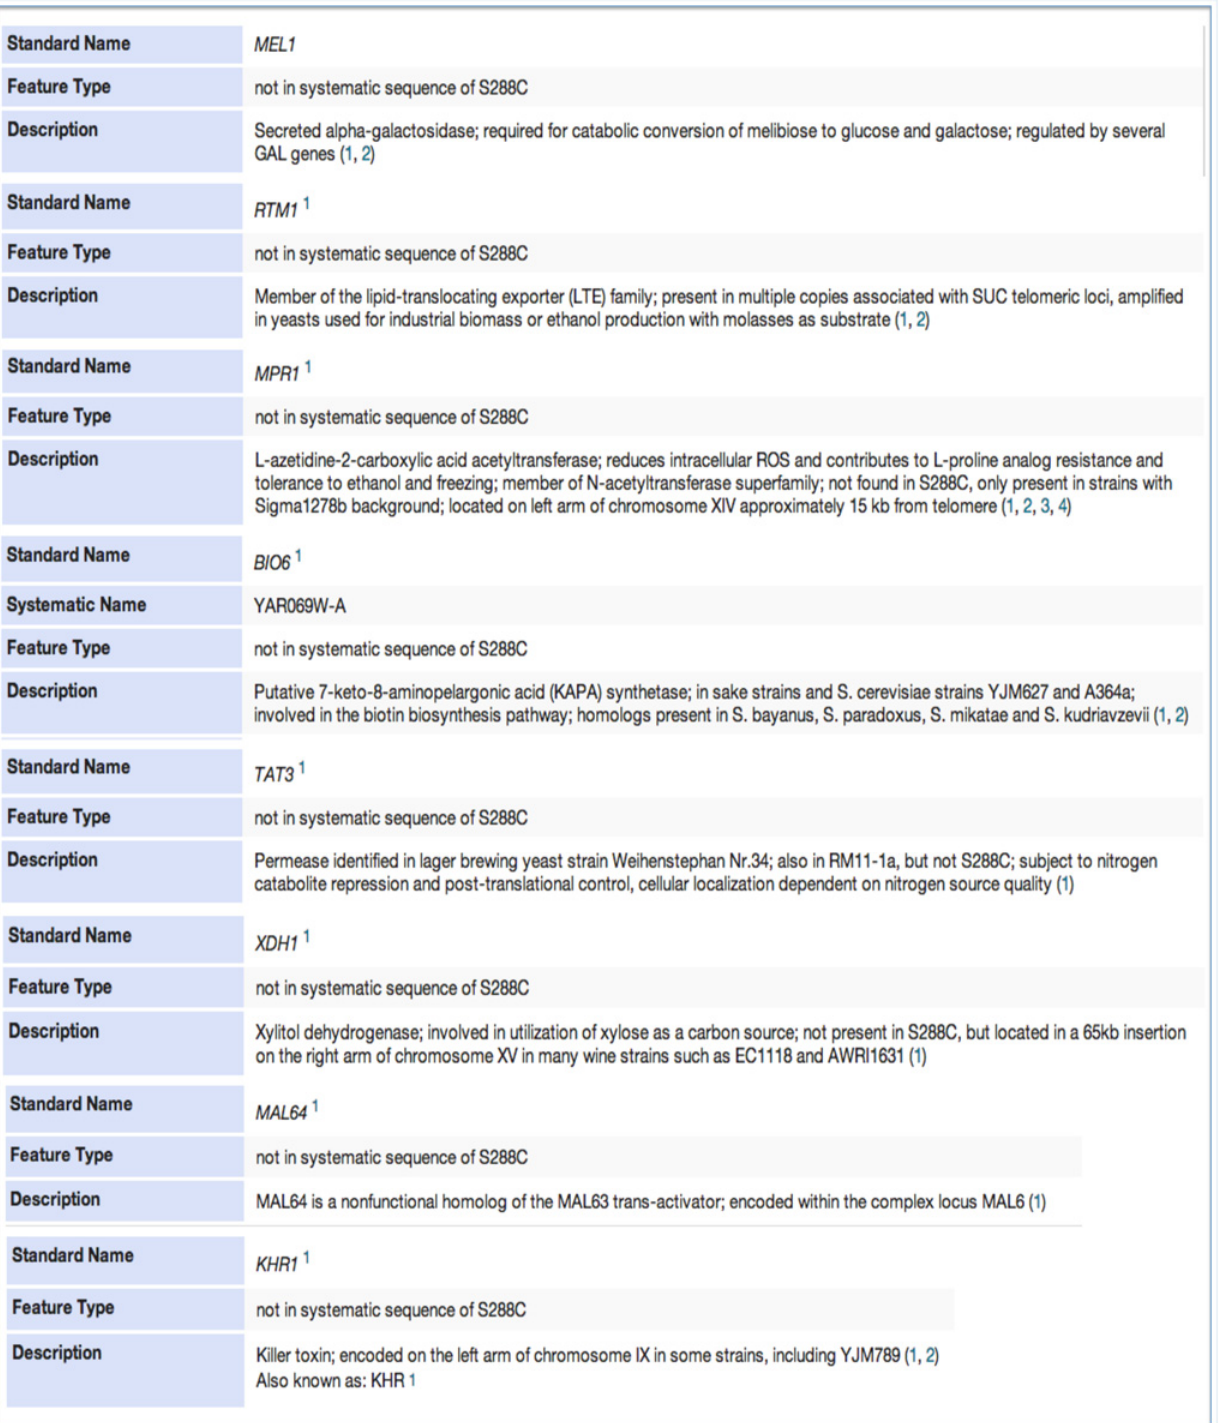
Fig 4. Known features not present in the reference genome. Annotations for 8 non-reference ORFs that were identified by our pipeline in 25 strains have been maintained in SGD. (a) MEL1 in D273, FL100, JK9, and UWOPS. (b) RTM1 in D273 and FL100. (c) MPR1 in JK9, RedStar, and Y55. (d) BIO6 in K11: K11 is a saké strain and this is consistent with the description that BIO6 is present in saké strains. (e) TAT3 in RM11_1A, SK1, UWOPS, YPS128, and YPS163. (f) XDH1 in RedStar and YS9. (g) MAL64 in K11, UWOPS, YPS163, YPS128, and 10560 – 6B. (h) KHR1 in BC187, YS9, FL100, YJM339, Y55, K11, YPS163, DBVPG6044, YPS128, and